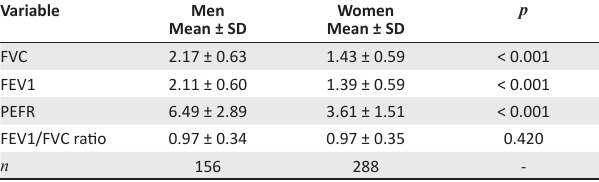
TABLE 2: Lung function parameters by gender ( n = 444).